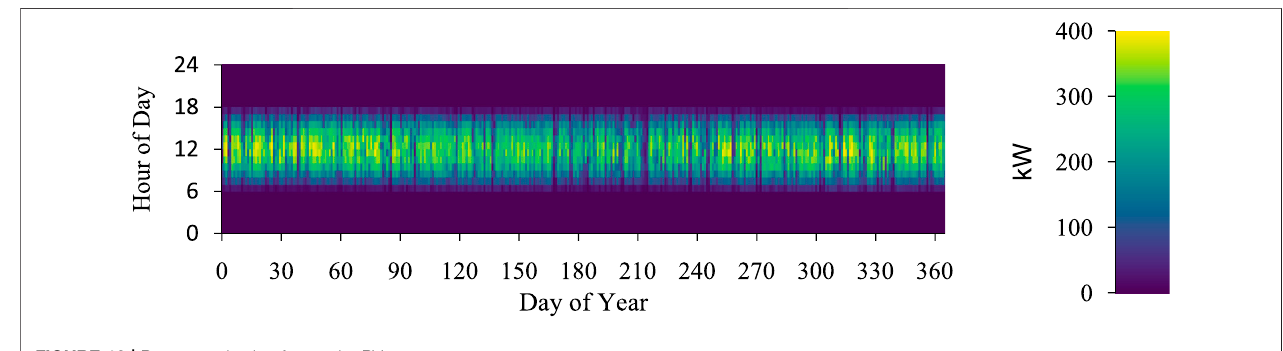
Frontiers in Energy Research |